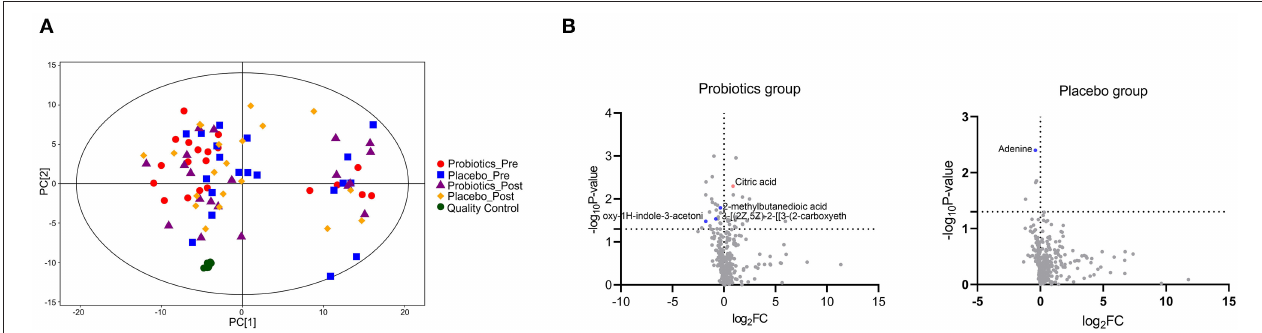
FIGURE 2 | Comparison of the plasma metabolites in the two groups (a total of 60 sample from 15 patients/group 1 day before the first cycle of docetaxel administration and 21 days after the last cycle of docetaxel administration.). (A) The principal component analysis (PCA) scores plots constructed with metabolites of samples of patients. (B) The differences between the two groups on metabolites based on Mann-Whitney test. Metabolites with significant intergroup difference throughout the treatment period (up-regulation: red points; down-regulation: blue points; no significant intergroup difference: gray points).